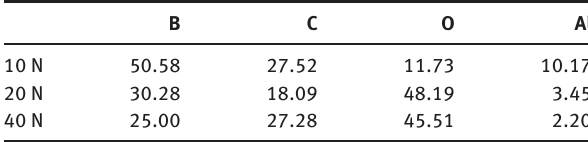
Table 4: EDX analysis of S4 worn